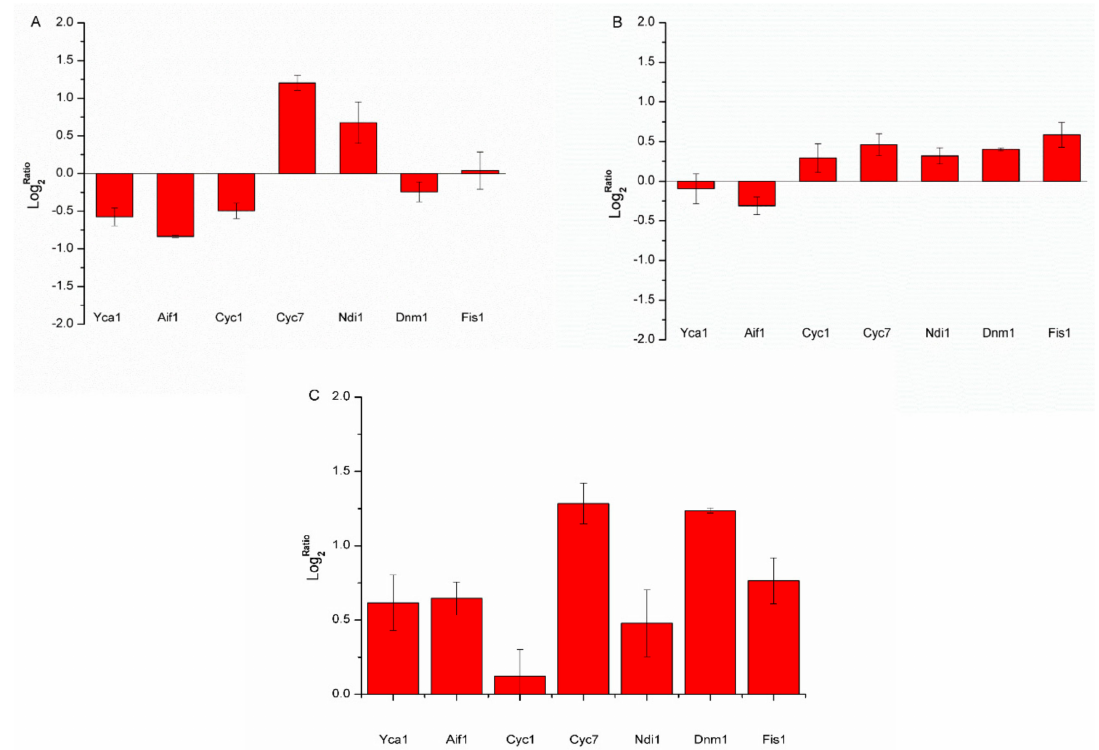
Figure 8. Fold changes (Log 2 ) in key genes involved in mitochondrial PCD, measured by qPCR. The cells were treated using 20 µ g / mL BetA for 4 h. The treatment by 20 µ g / mL DMSO was used as the solvent blank. RNAs were purified from the samples collected and used in qPCR analyses. Data are presented as Log2Ratio and are normalized to actin gene. If the Log 2 Ratio = 0, the expression level of this gene was not changed. ( A ) Compared with the DMSO group, seven genes changes after BetA treatment in the wild-type strain. ( B ) Compared with the DMSO group, seven genes changes after BetA treatment in the ∆ pep4 strain. ( C ) Compared with the wild-type strain treated by BetA, seven genes changes after BetA treatment in ∆ pep4 one. Each value represents the mean of three independent